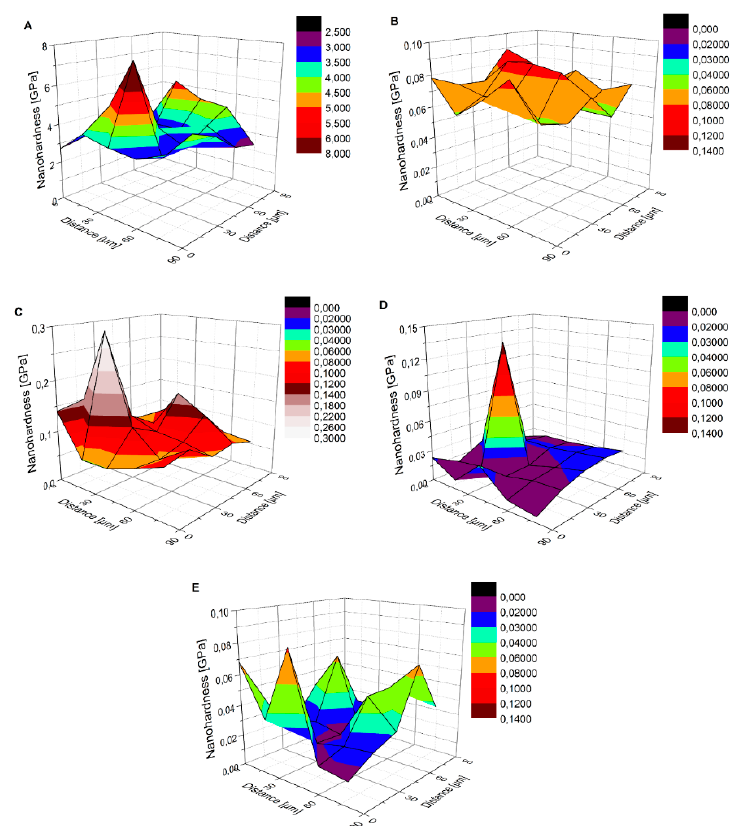
Figure 5. 3D nanohardness distribution for ( A ) native material after grinding (MR), ( B ) native material after etching (MRe), ( C ) CNTs coating (0.27CNT), ( D ) CNTs deposited on HAp coating (H0.27CNT),